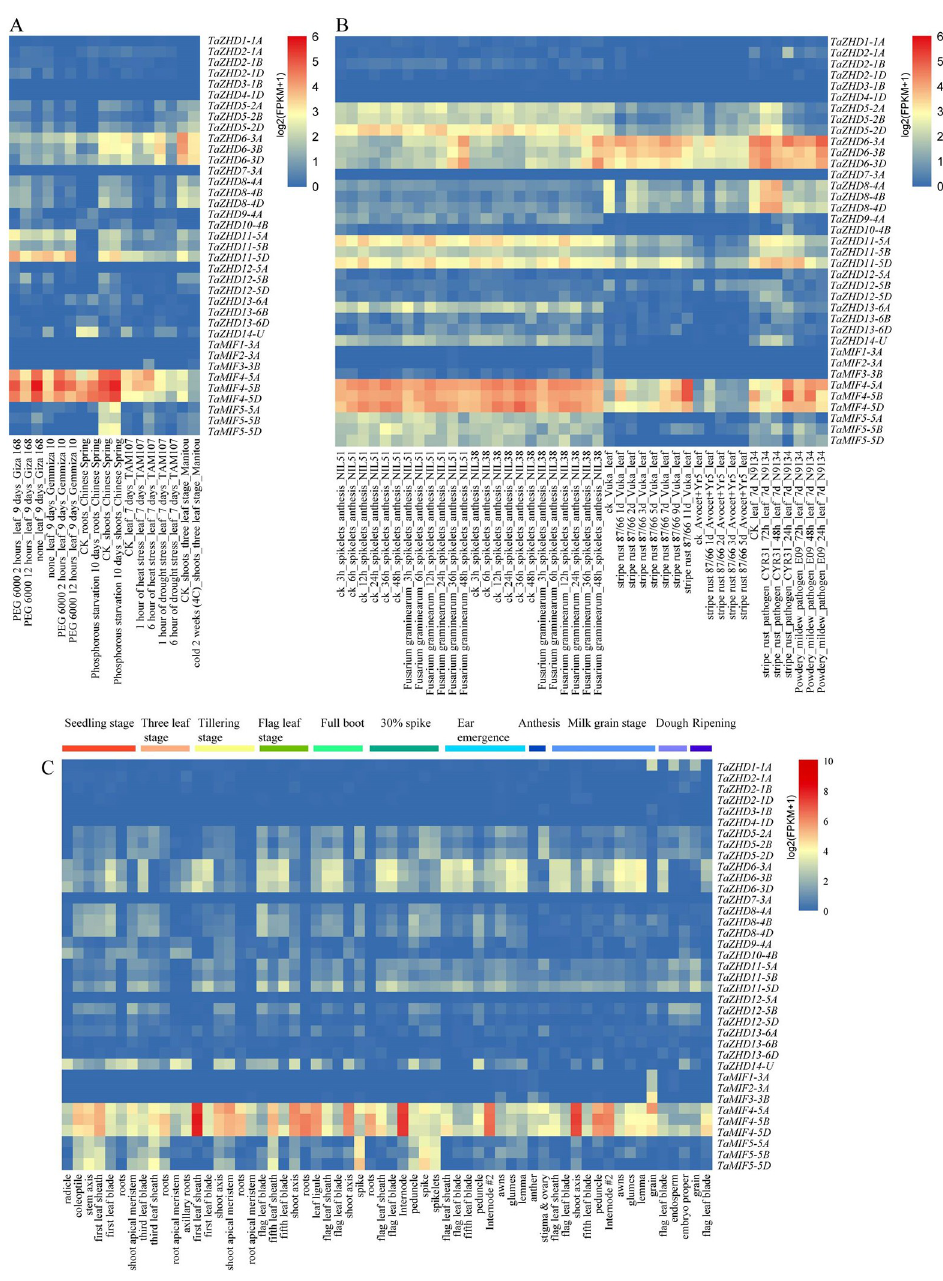
Fig 6. Multi-conditional transcriptome analysis of TaZF-HDs in different tissues and different biotic/abiotic stress environments. The R package ‘pheatmap’ was used to generate the heat maps. ( A ) Transcript level of TaZF-HDs responding to abiotic stresses; ( B ) Transcript level of TaZF-HDs responding to biotic stresses. ( C ) Transcript level of TaZF-HDs in wheat different tissues and development